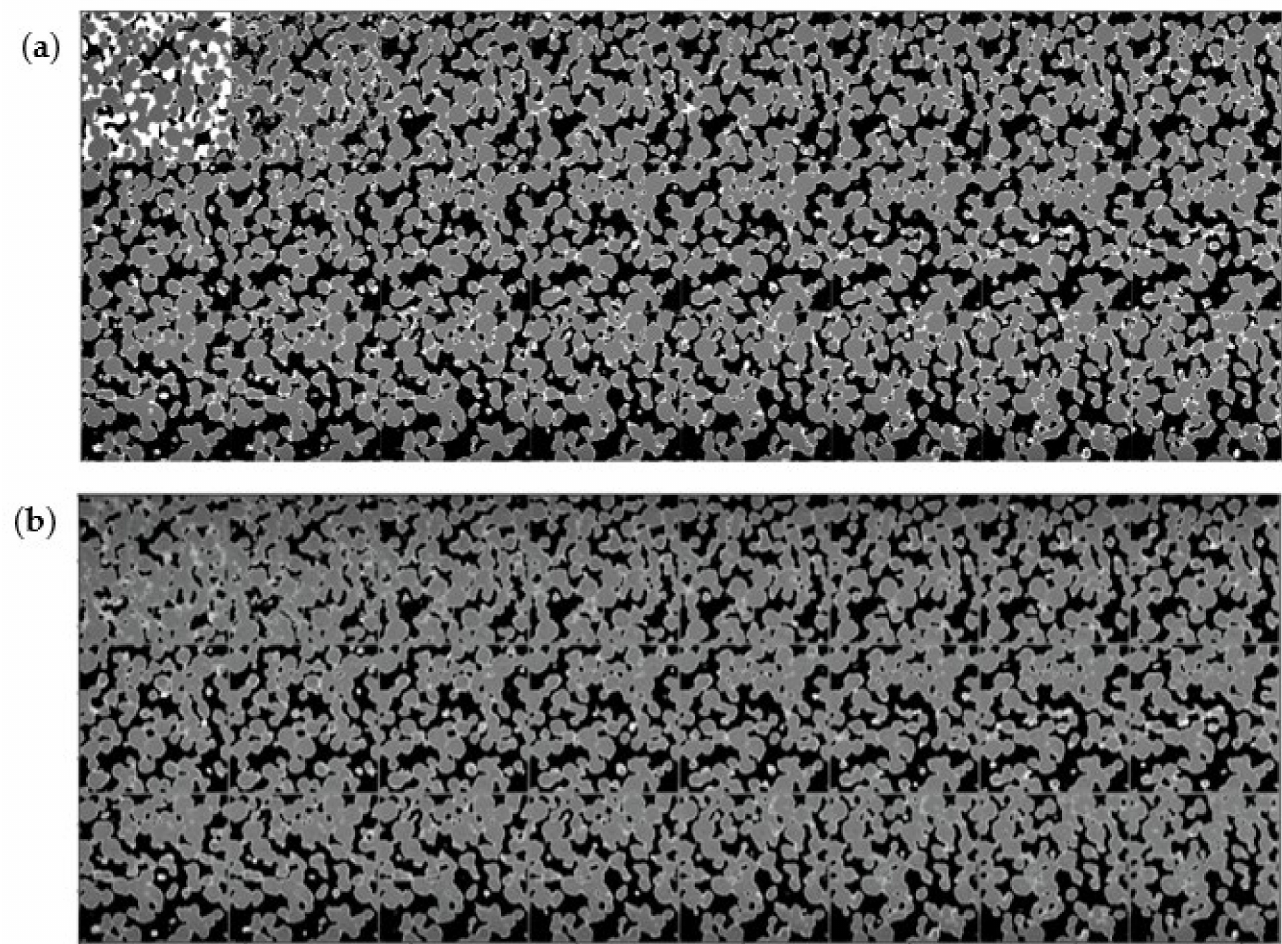
Figure 7. ( a ) A sample 3D calendered mini microstructure with size 24 × 224 × 224 ( b ) Reconstructed 3D microstructure from sample microstructure using the 3-layer 3D CAE trained on the dataset created with a sliding window length 24 and stride